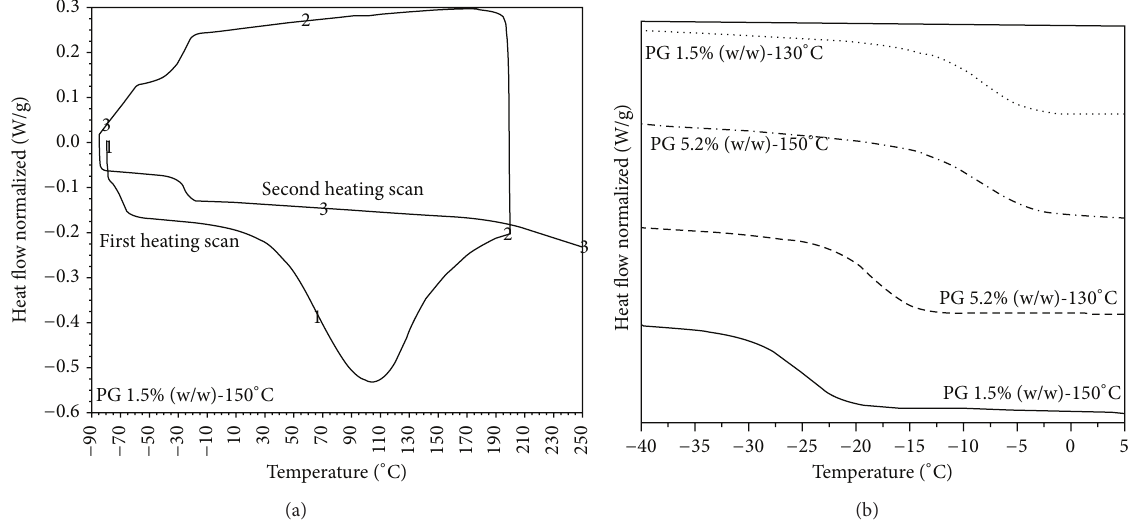
Figure5:(a)FirstandsecondheatingscanDSCresultsforpolyglycerolsynthetizedwithcatalystconcentrationof1.5%(w/w)andtemperature of 150 ∘ C. (b) Polyglycerol glass transition temperatures found in the second heating